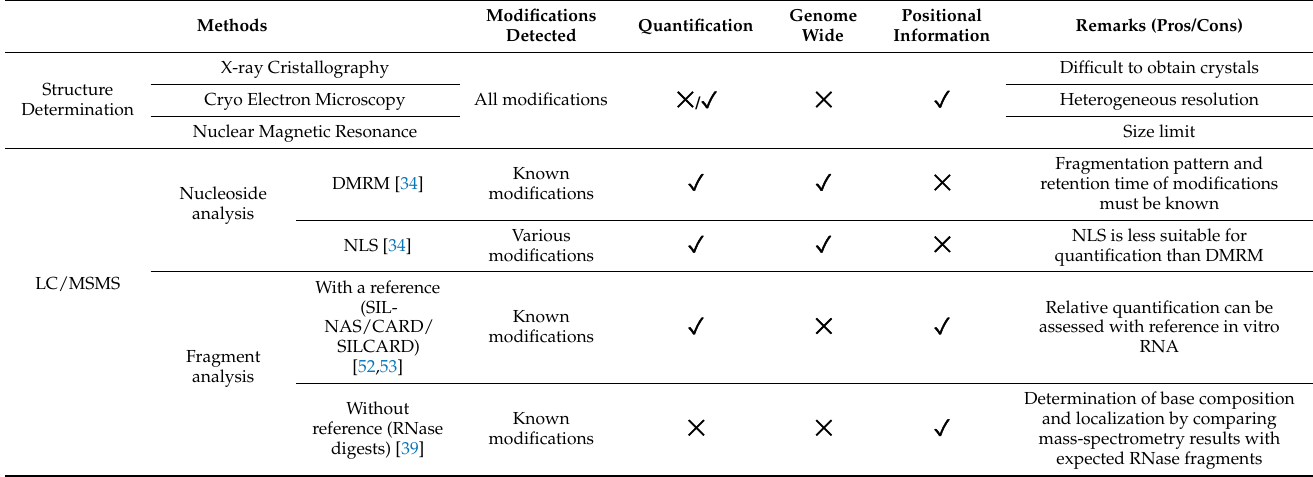
Table 1. Summary of main techniques for the detection of RNA